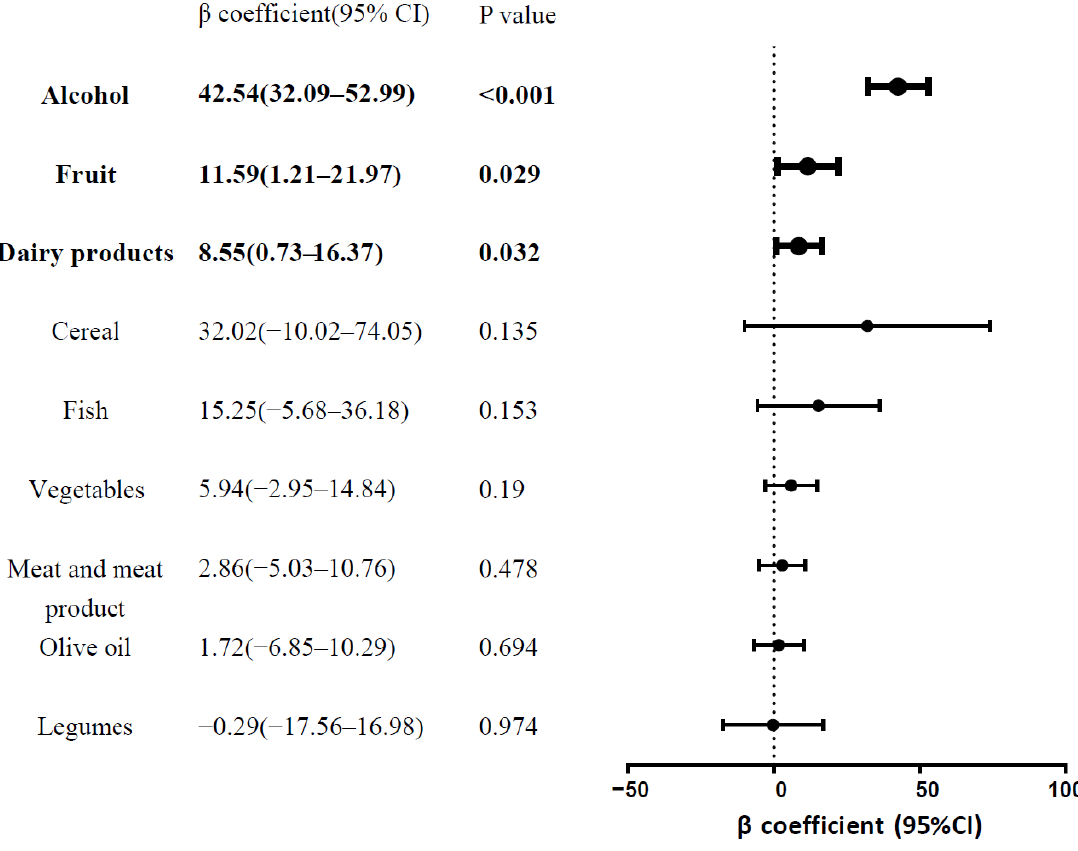
Figure 3. Forest plot of β coefficients presenting the association between nine components in the Mediterranean diet adherence score and s-Klotho levels as outcome. The β coefficient discloses the degree of change in s-Klotho levels for each 1-score increase in an individual component. Components that revealed significant associations are highlighted in